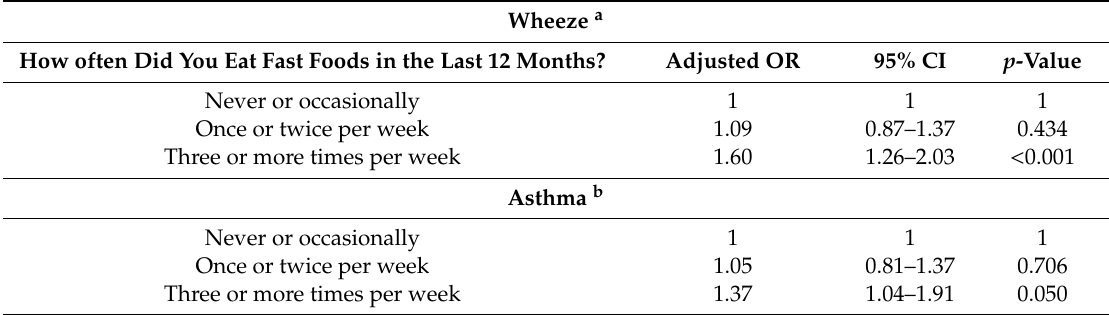
Table 4. Adjusted odds ratios of wheeze, asthma and fast foods among the study participants ( n = 3641). Wheeze